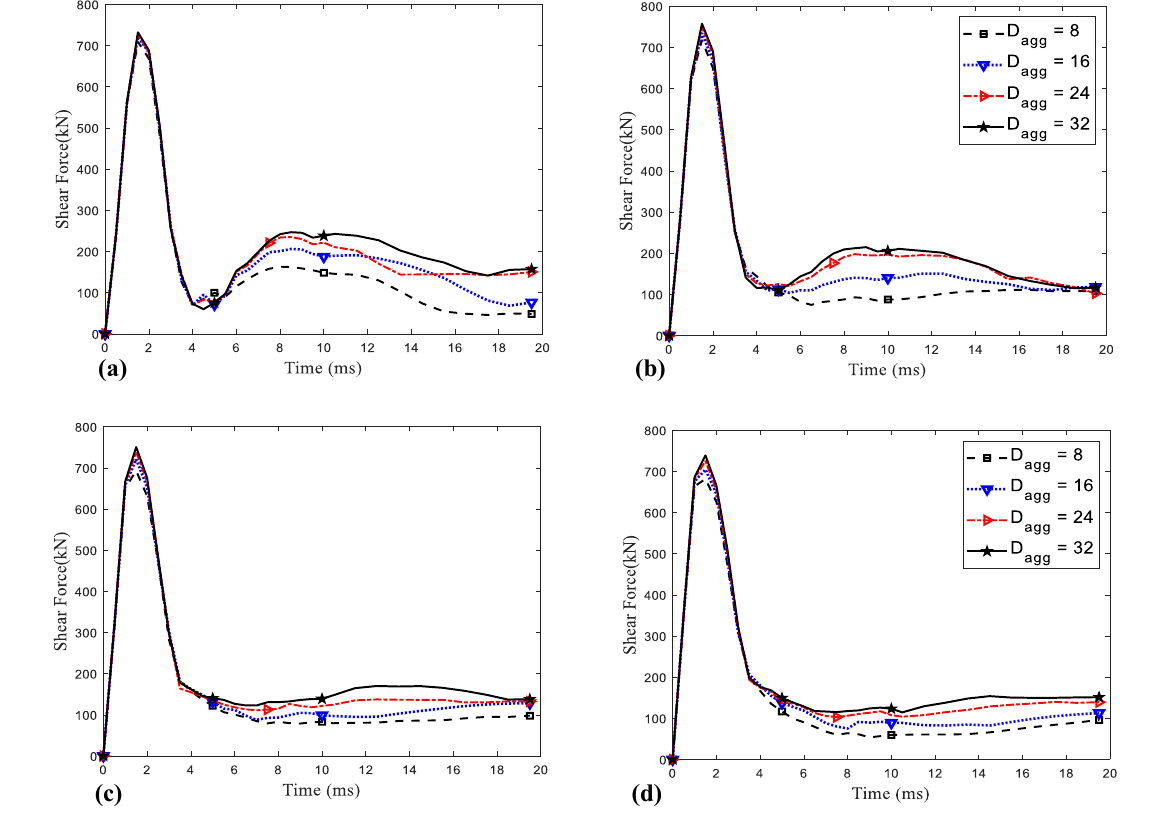
Fig. 12 Time history plots of the critical section shear force a CV1, b CV2, c CV3 and d CV4